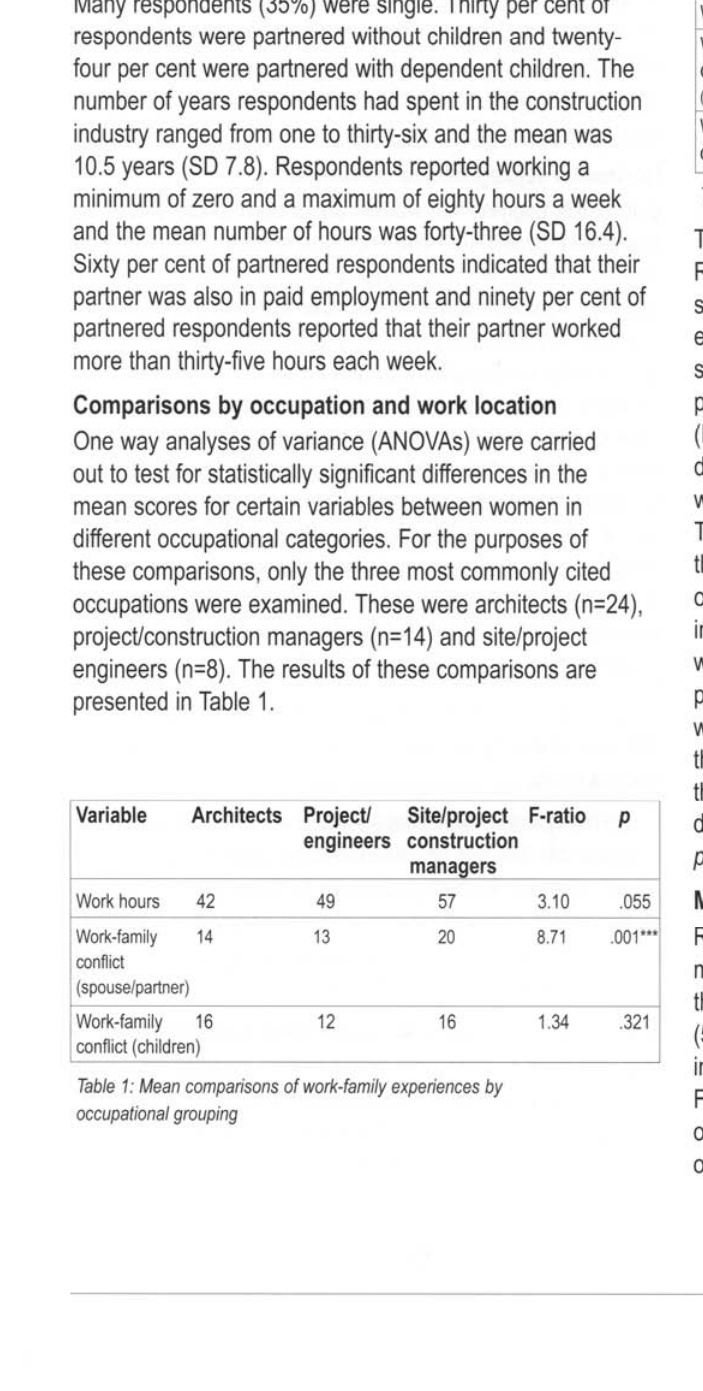
Table 1: Mean comparisons of work-family experiences by occupational grouping